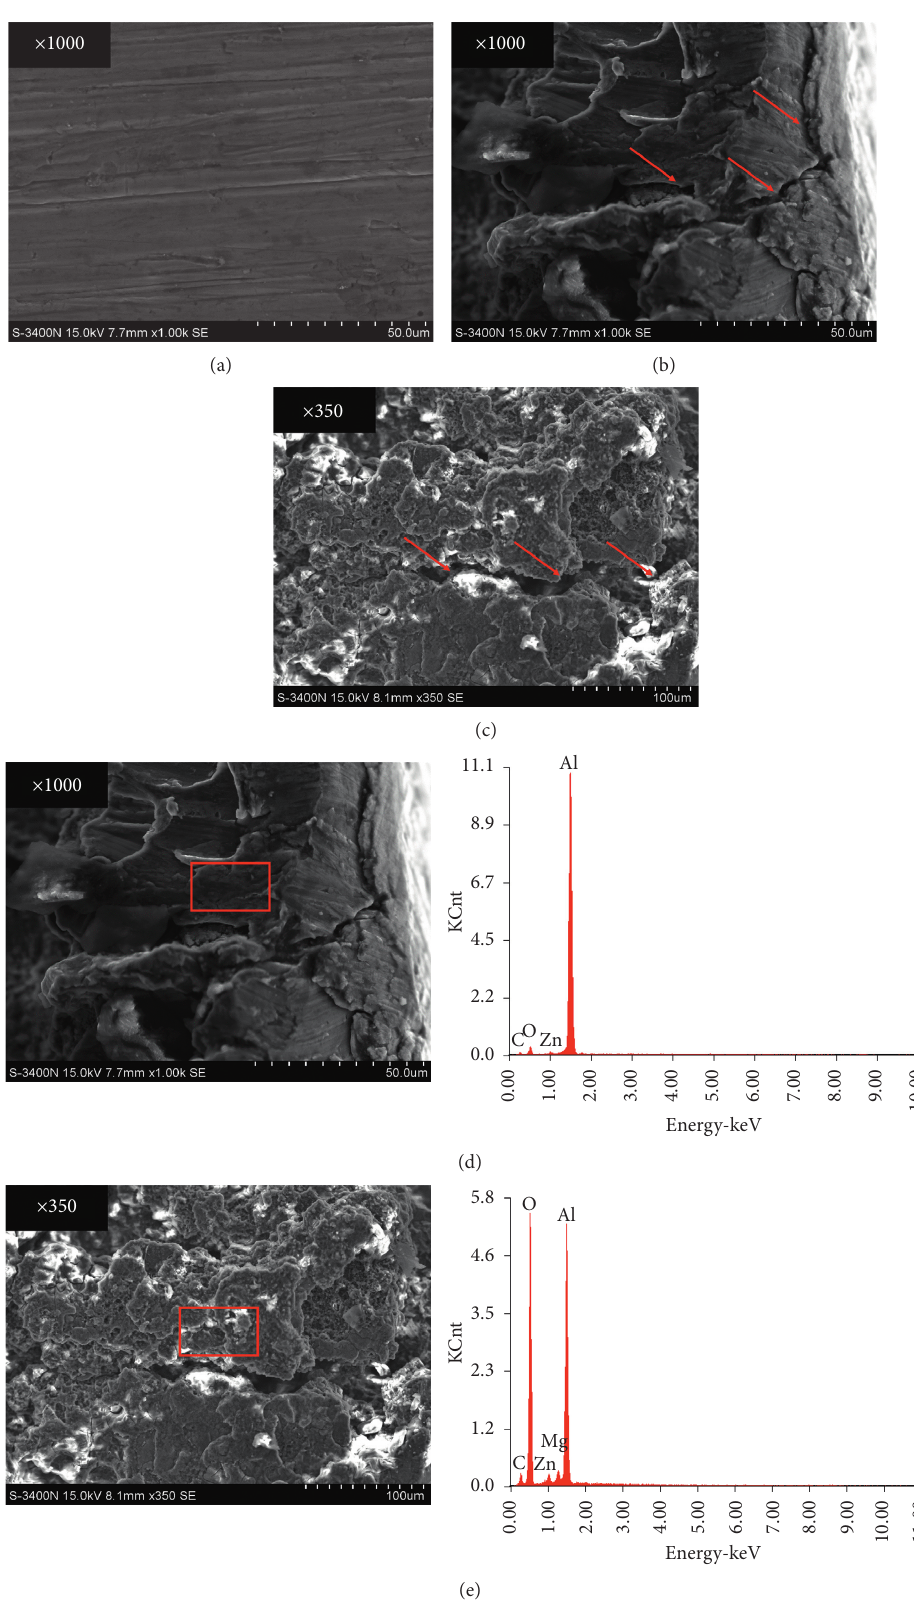
Figure 13: SEM and EDS images of crack initiation and obvious propagation time. SEM: (a) 7A04 aluminum alloys. New corrosion inhibitor at (b) crack initiation time and (c) crack propagation time. SEM and EDS images at (d) crack initiation time and (e) crack obvious propagation